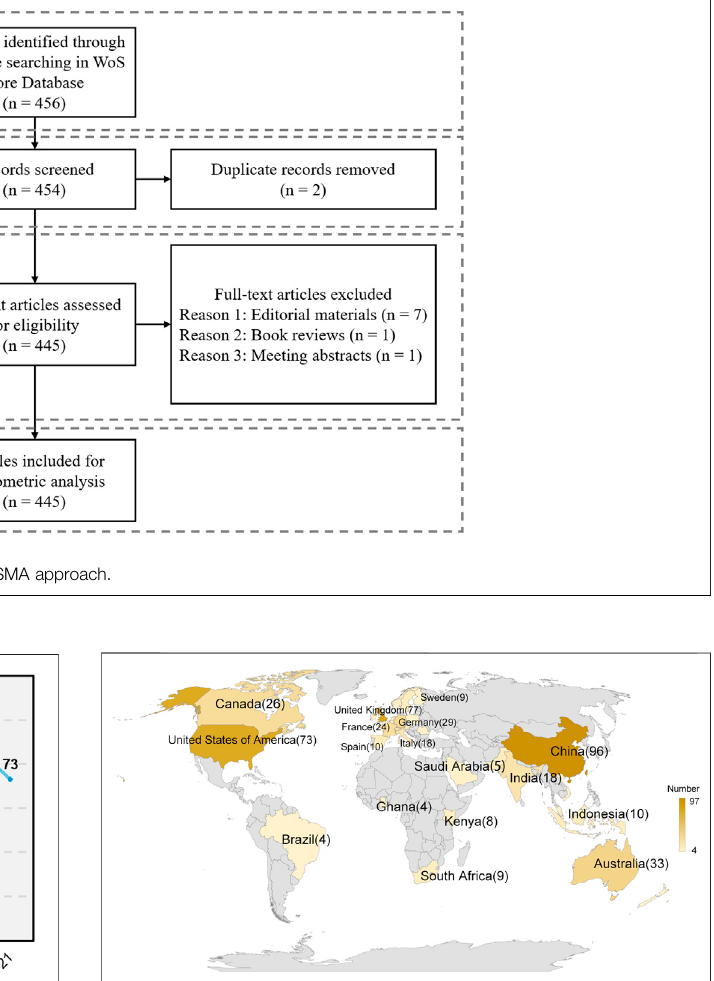
FIGURE 3 | Number of publications from 2011 to August 2021.